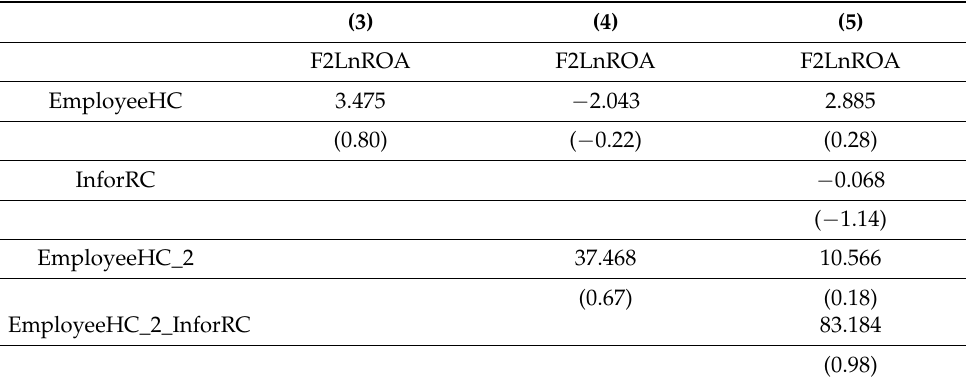
Table A4. Results of the panel regression with fixed effects (firm and